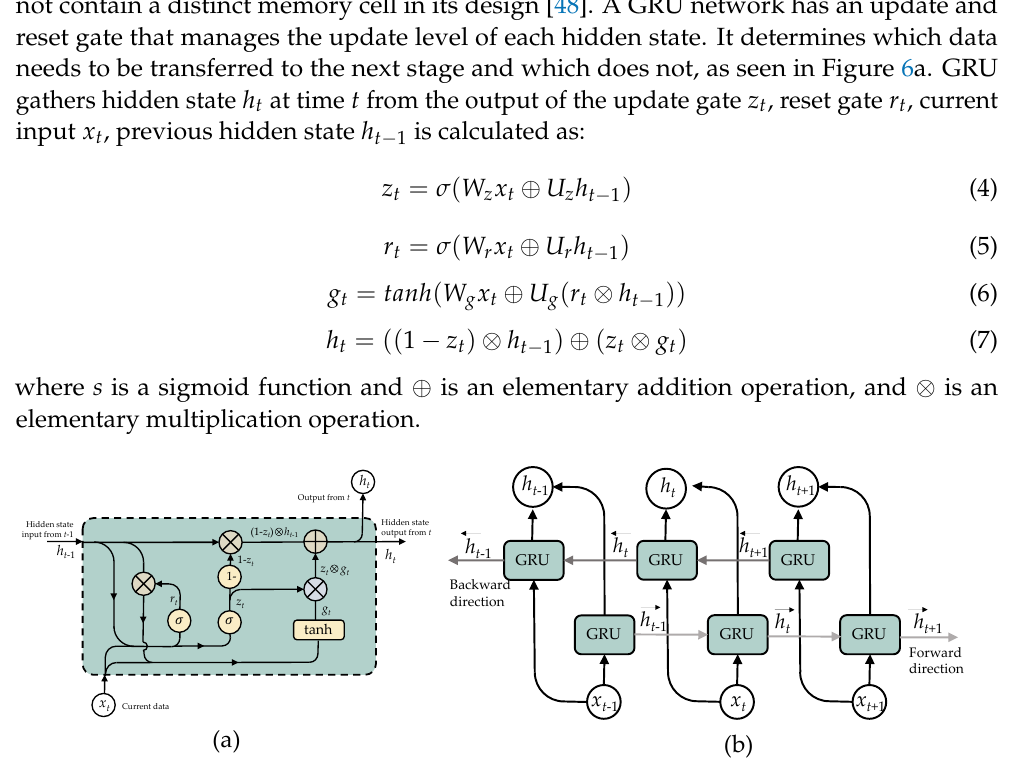
Figure 6. Structure of Bidirectional GRU (BiGRU): ( a ) GRU cell and ( b ) unroll